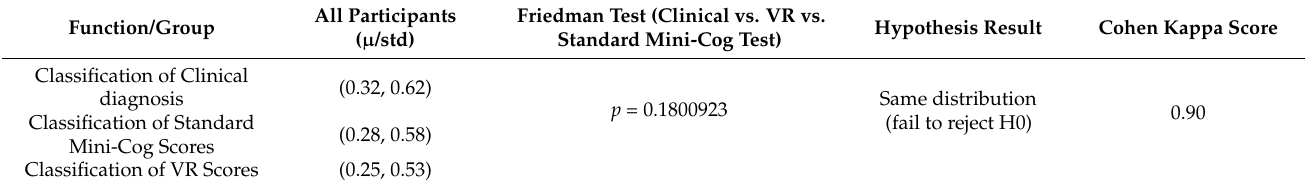
Table 4. Friedman test and Cohen kappa of cognitive test in clinical diagnosis vs. VR system vs. standard Mini-Cog test. All Participants Friedman Test (Clinical vs. VR vs. Function/Group ( µ /std) Standard Mini-Cog